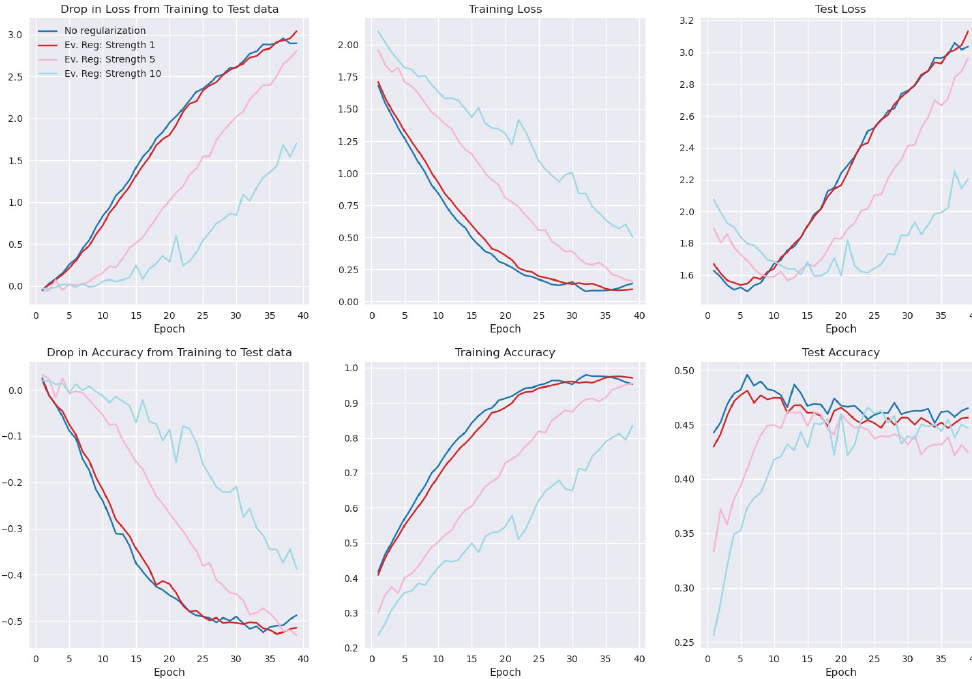
Figure 8. Loss and accuracy for CIFAR-10 for training and test data.